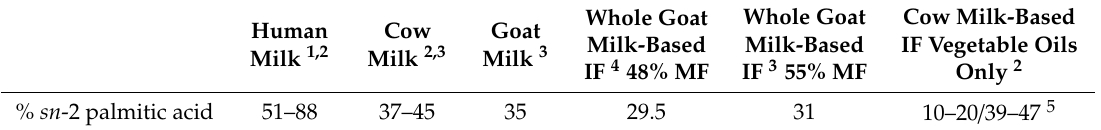
Table 2. sn -2 palmitic acid percentage in human milk, cow milk, goat milk and whole goat milk-based infant formula.